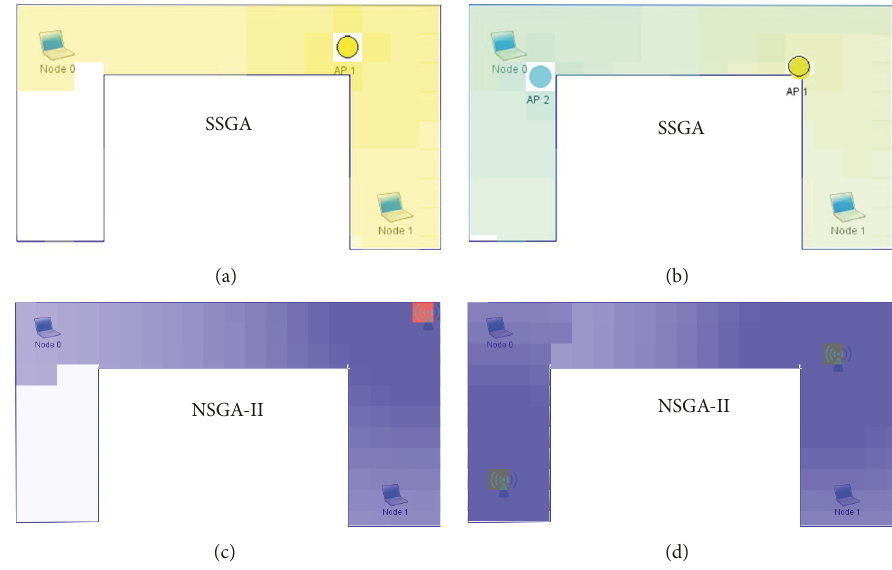
Figure 4: Comparison of solutions for SSGA and NSGA-II on a small scenario: (a)–(c) one AP and (b)–(d) two APs.